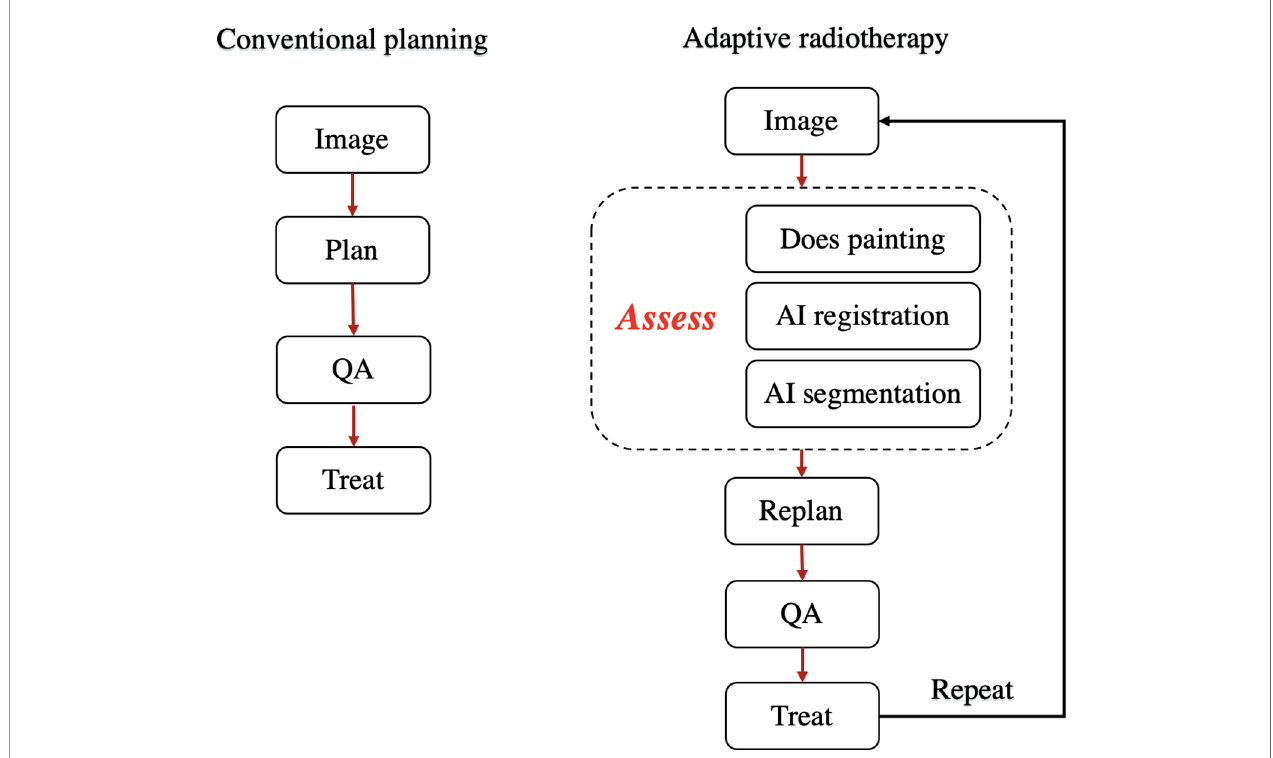
FIGURE 3 | Work fl ow of conventional and adaptive radiation therapy